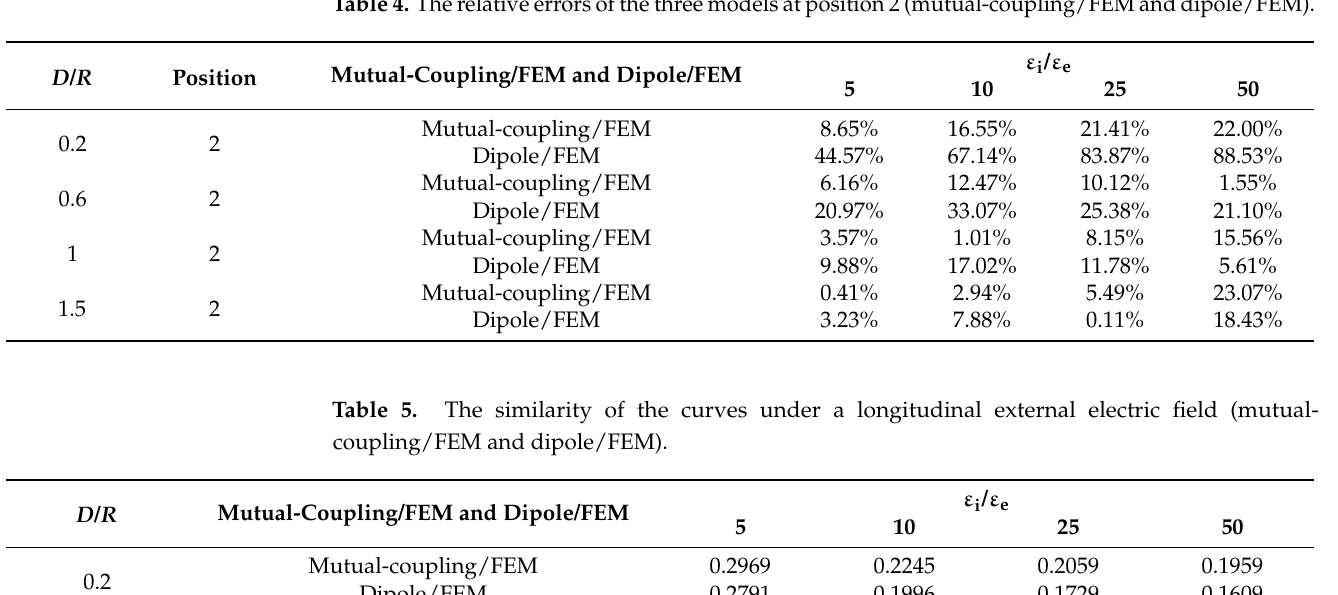
Table 4. The relative errors of the three models at position 2 (mutual-coupling/FEM and dipole/FEM).